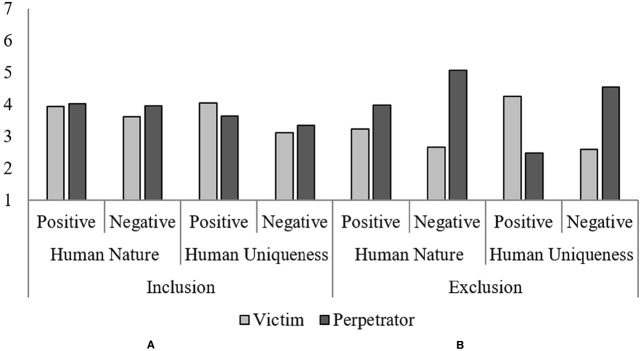
Human Nature and Human Uniqueness scores. The left side (A) and the right side (B) depict the Inclusion and Exclusion conditions, respectively.